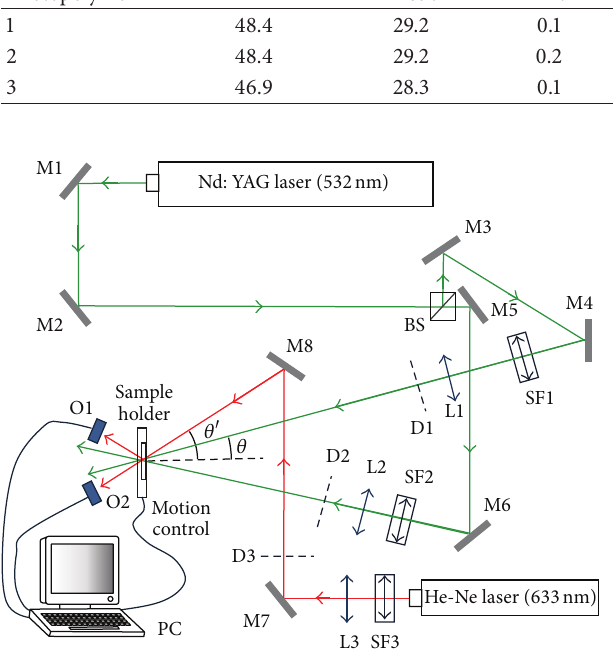
Figure 1: Experimental setup. BS: beamsplitter, Mi: mirror, SFi: spa- tial filter, Li: lens, Di: diaphragm, Oi: optical power meter, and PC: data recorder.